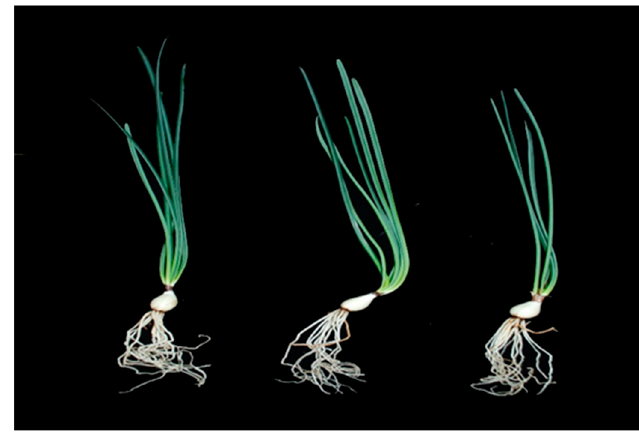
Figure 2. The phenotype of L. radiata grown in a growth chamber.